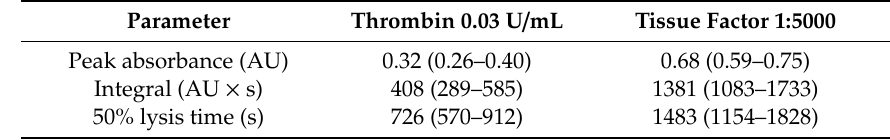
Table 2. Clot-lysis parameters with tissue factor vs.